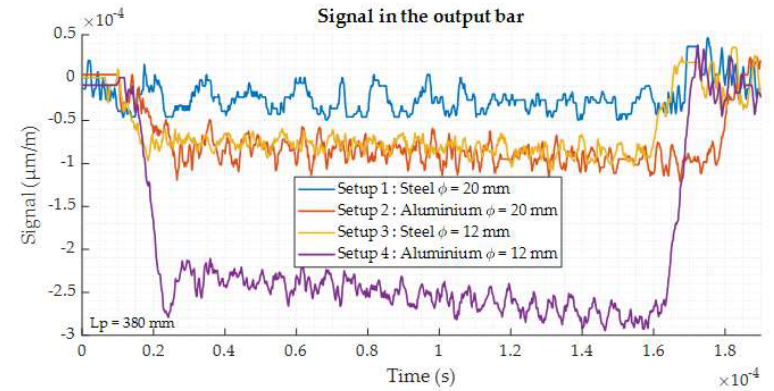
Figure 8. Output signal for the different setups obtained by numerical simulation.